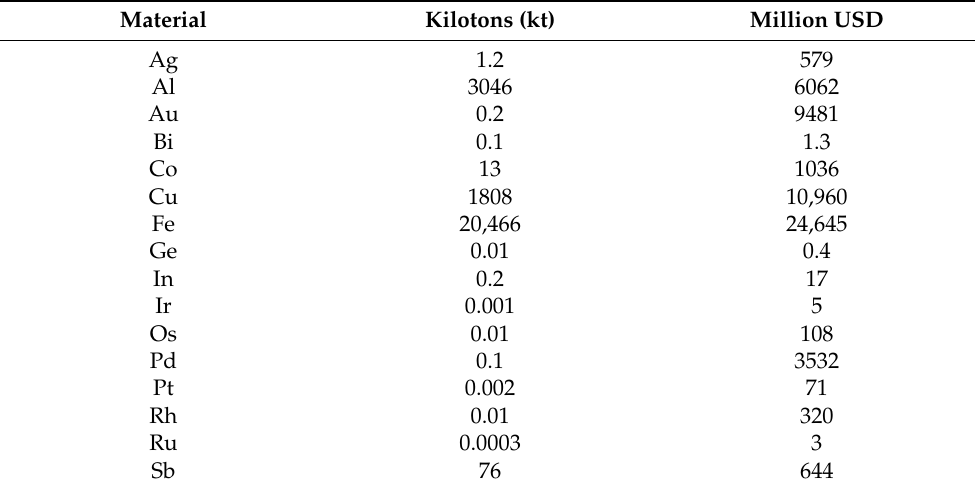
Table 1. The potential value of the analyzed raw materials in e-waste in 2019. Material Kilotons (kt) Million USD Ag 1.2 579 Al 3046 6062 Au 0.2 9481 Bi 0.1 1.3 Co 13 1036 Cu 1808 10,960 Fe 20,466 24,645 Ge 0.01 0.4 In 0.2 17 Ir 0.001 5 Os 0.01 108 Pd 0.1 3532 Pt 0.002 71 Rh 0.01 320 Ru 0.0003 3 Sb 76